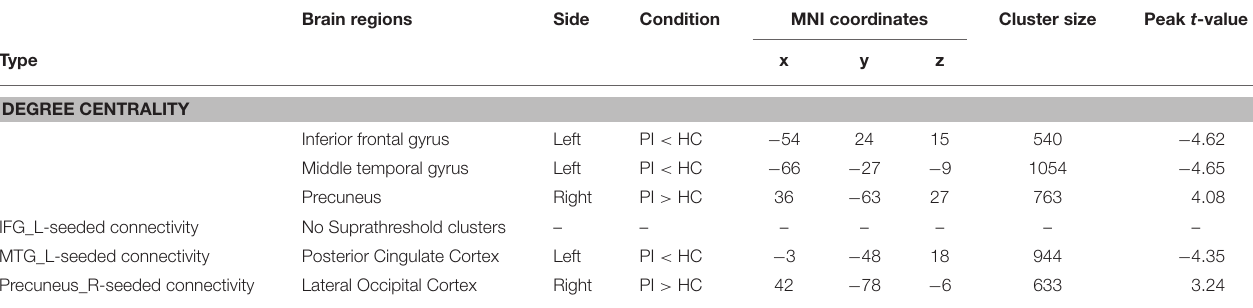
TABLE 1 | Significant differences in degree centrality ( r 0 = 0.25) and functional connectivity between two groups.